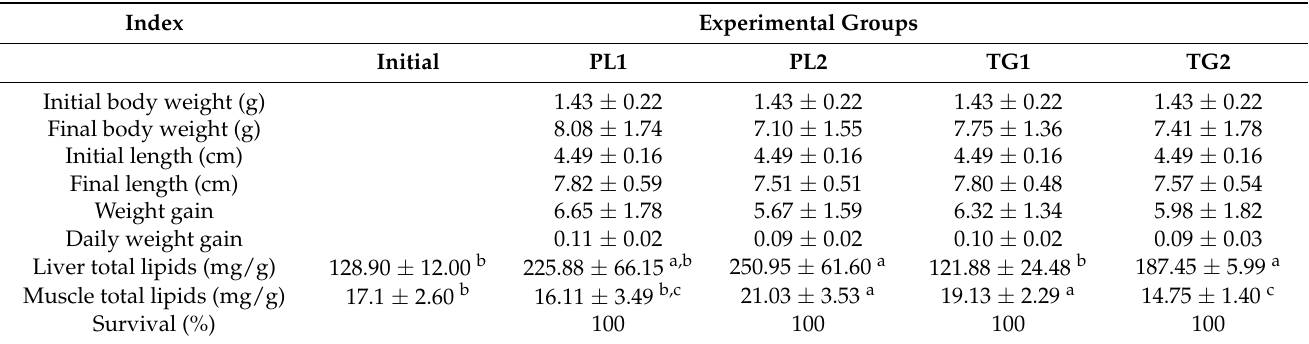
Table 4. Effects of dietary DHA and EPA as PL and TG on growth performance, survival, and body parameters of dusky grouper juveniles fed experimental diets for 8